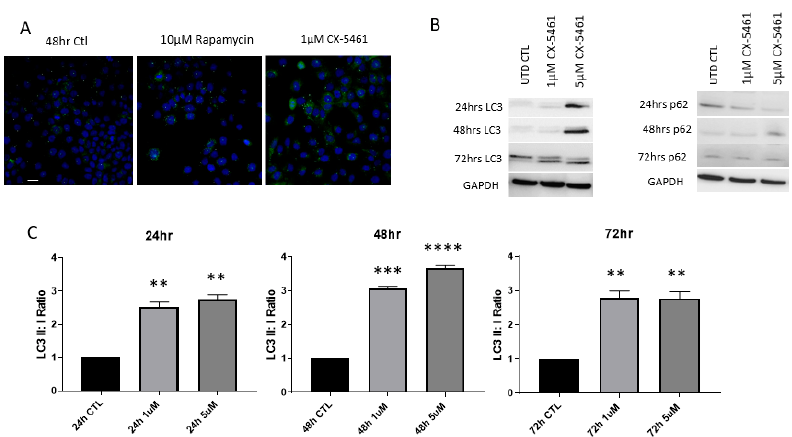
Figure 5. CX-5461 treatment and the induction of autophagy. CaSki cells were treated with 1 µM CX-5461 for 48 h and stained for LC3 puncta using anti-rabbit LC3 (1:1000) and counterstained with DAPI. Rapamycin treatment, a known inducer of autophagy was used as a positive control ( A ). Distinct visualization of